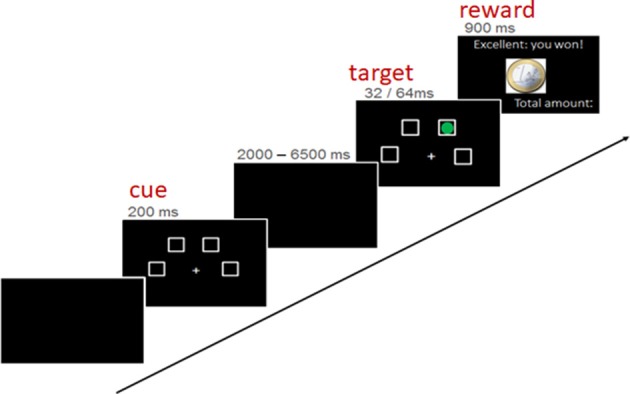
Structure of an experimental trial.